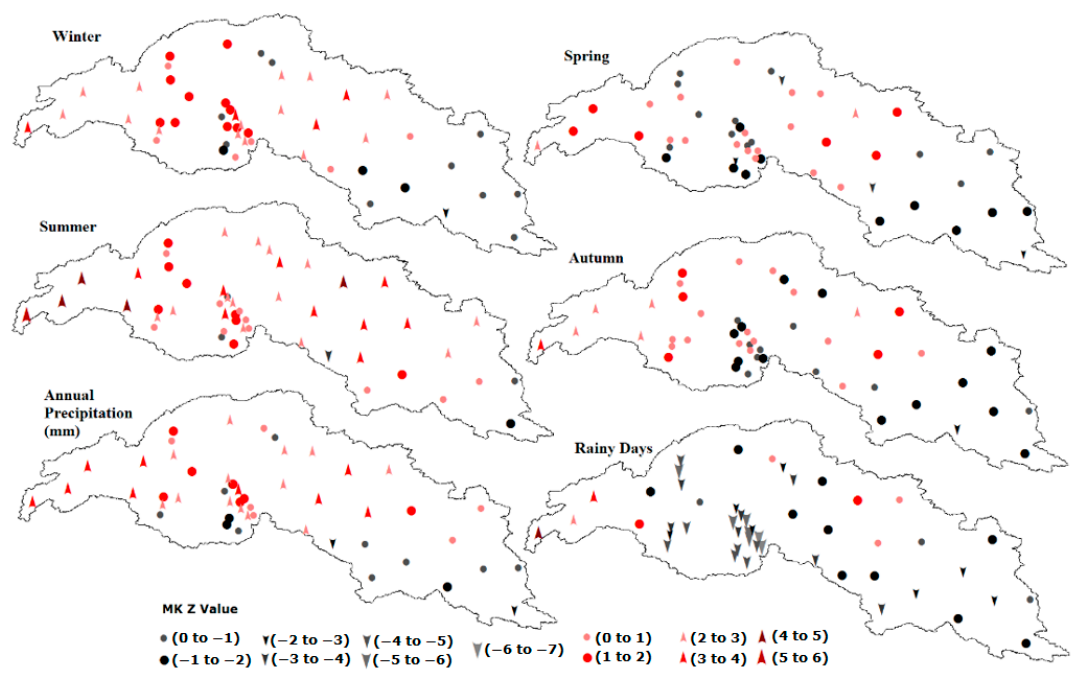
Figure 8. Trends in seasonal precipitation, annual precipitation, and rainy days.